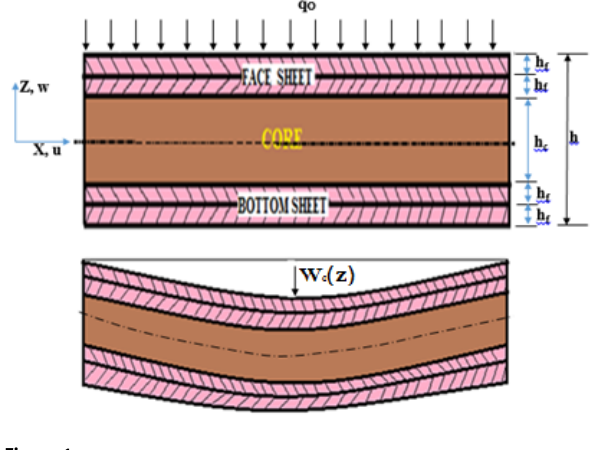
Uniformly distributed load is applied over facesheet of sandwich beam shown by q and W is the transverse cen- o o tral deflection occurred in sandwich beam along z direc- tion. In present analysis along with uniformly distributed load, hydrostatic, point and sinusoidal loading is applied over the face sheet of sandwich composite beam. Figure 2 shows the nature of these different